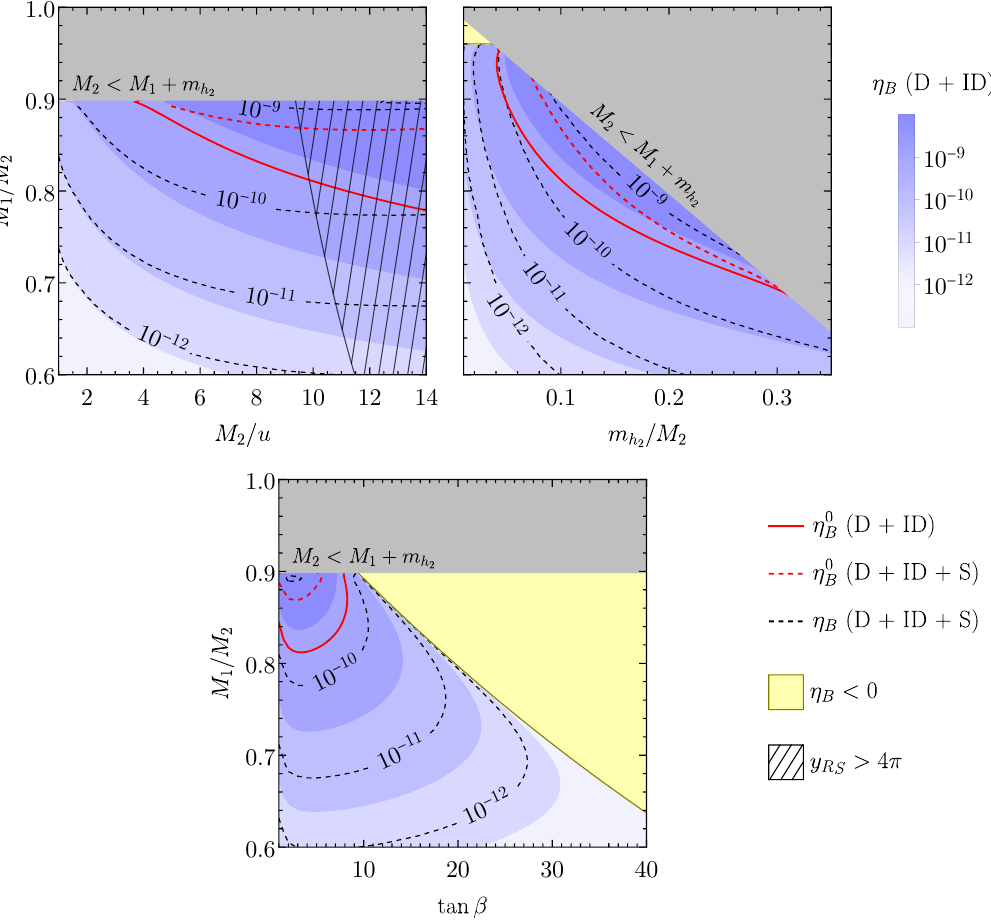
Figure 7 . Top left: η B in the plane ( M 2 /u, M 1 /M 2 ) with m h /M 2 = 0 . 1 and t β = 3 . Top right: η B 2 in the plane ( m ) with y = 4 π and t = 3 . Bottom: η in the plane ( t ) h 2 /M 2 , M 1 /M 2 R S β B β , M 1 /M 2 with y = 4 π and m = 0 . 1 . In all plots, x , y , z , θ and θ are fixed to their best-fit R S h 2 /M 2 L value for case Z µ (see table 4), m = 0 . 37 and u = 10 12 GeV. In the grey regions one has h 1 /m h 2 8 , while in the hatched area y 4 π . In the yellow region η 0 . The black M 2 < M 1 + m h R S > B < 2 dashed contours and the blue regions correspond to η values computed with and without ∆ L = 1 B and ∆ N = 2 scattering terms in the BEs, respectively. The red dashed (solid) line indicates the observed baryon asymmetry [see eq. (3.2)] when the same terms are (not)